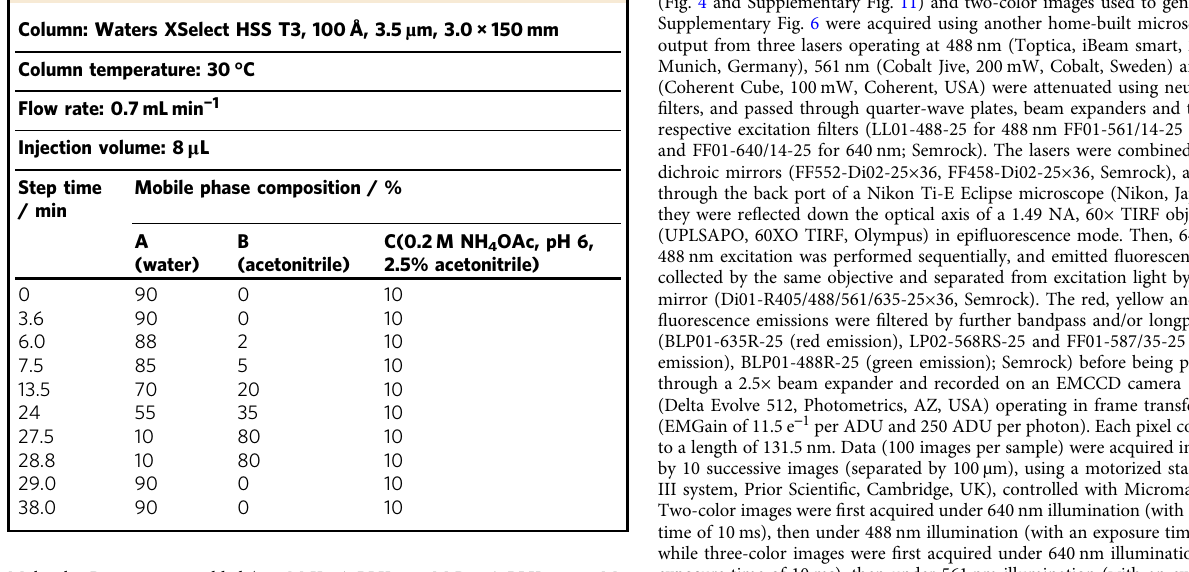
Table 3 HPLC conditions for analysis of digested ribosomal